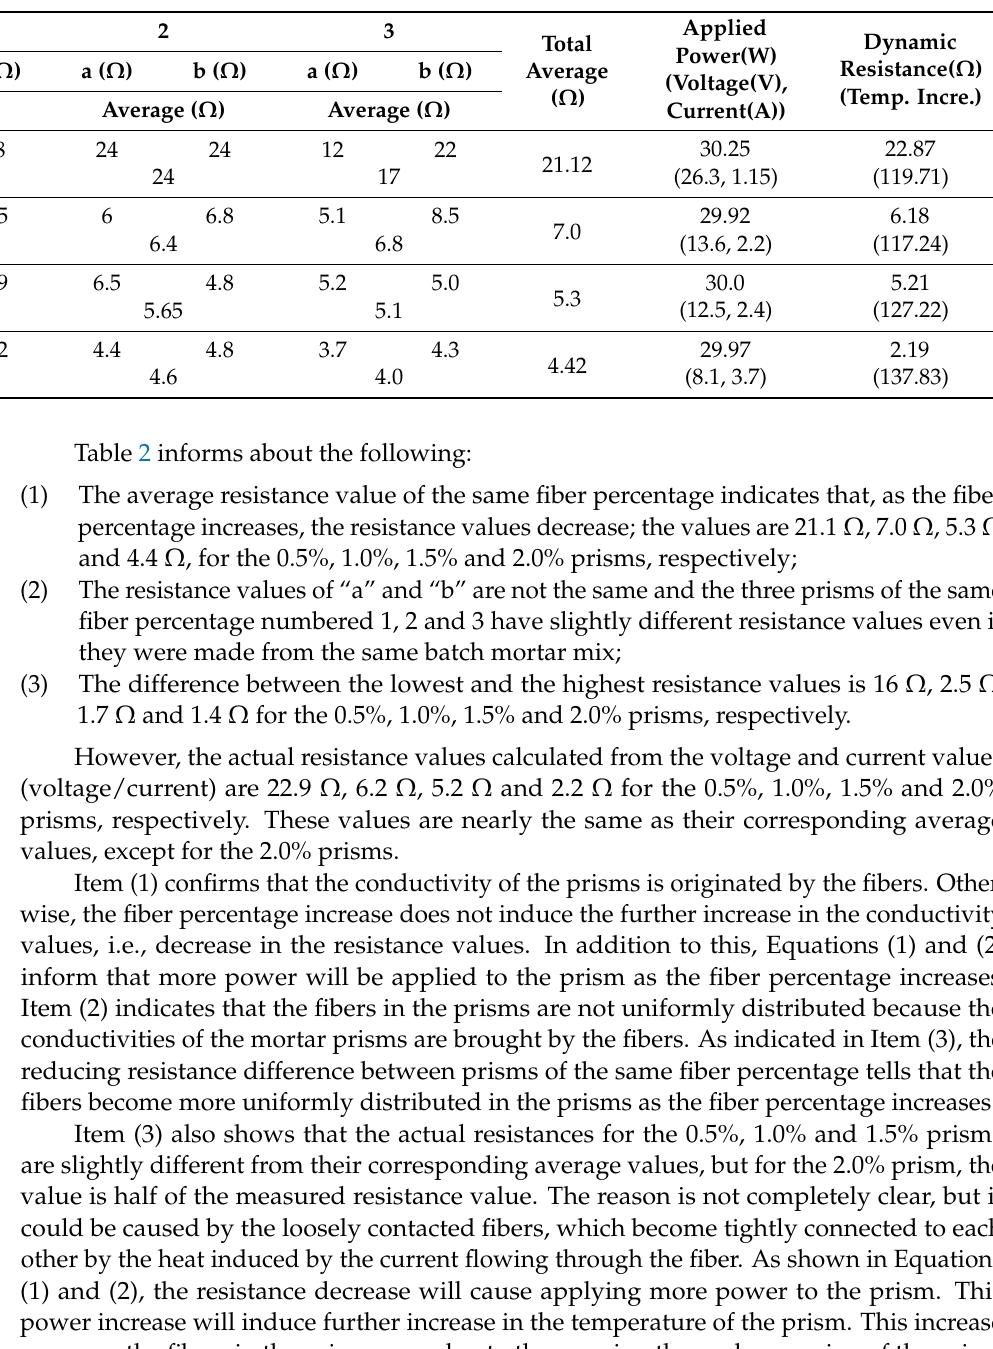
Table 2. Measured and calculated resistances of prisms of 4 different